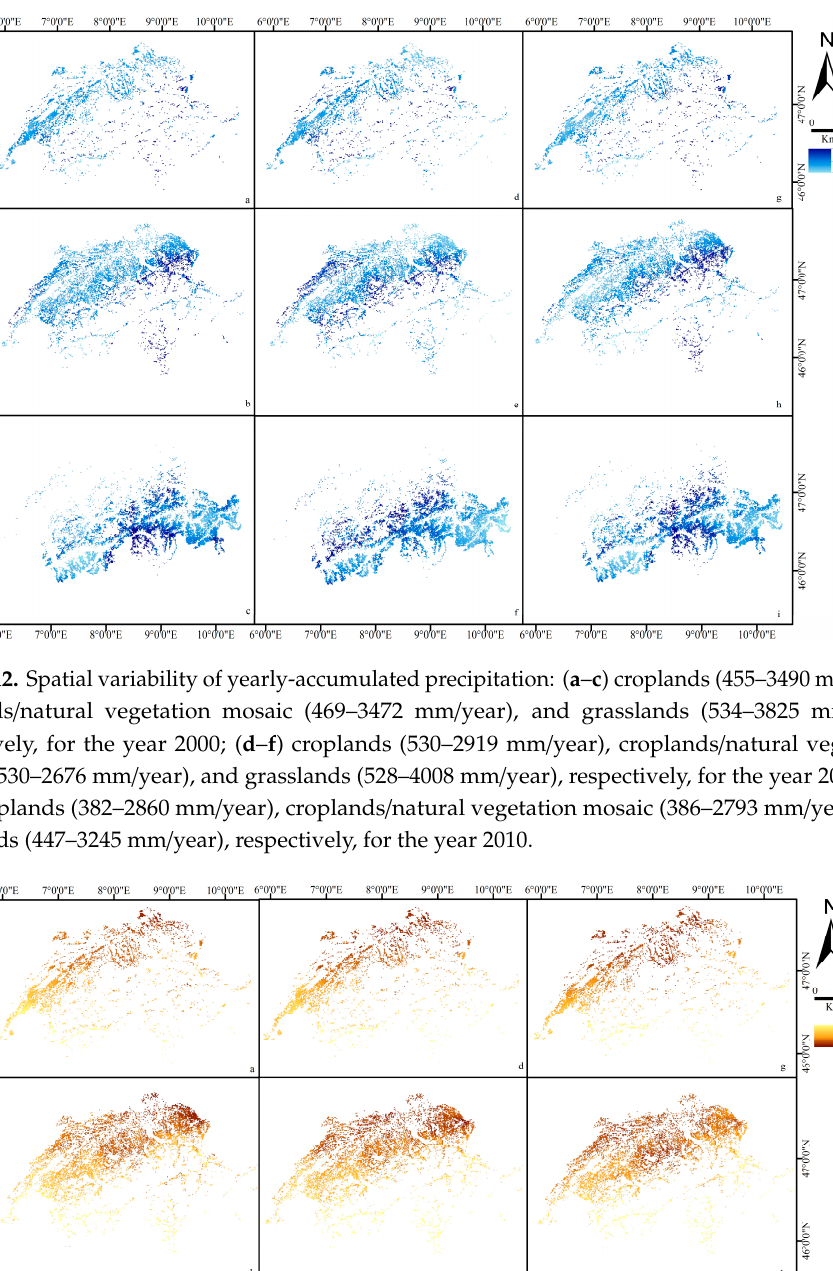
Figure A1. Spatial variability and statistics of Nitrogen deposition maps per year. Units: kg N/ ha year.